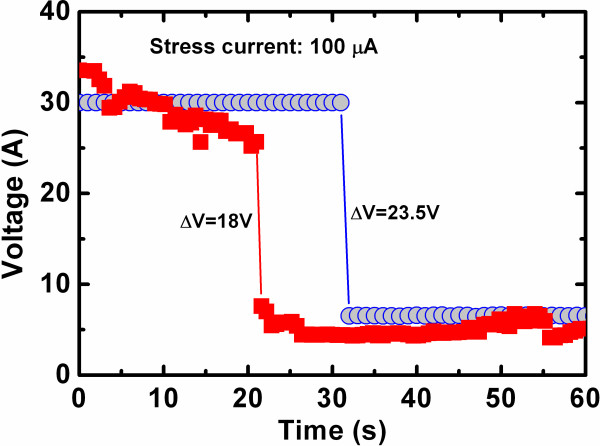
Evolution of voltage shift under constant current stress on the MIM structure. The voltage shift is caused by the filament or NW formation in the GeOx film.